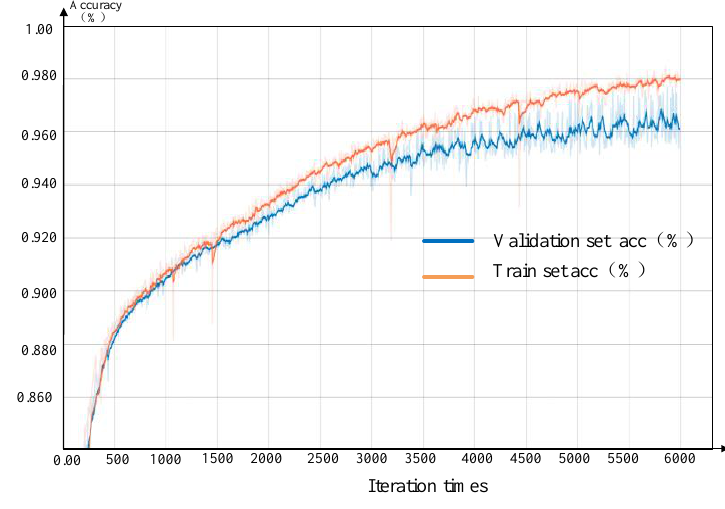
Figure 17. Training accuracy of FCN.